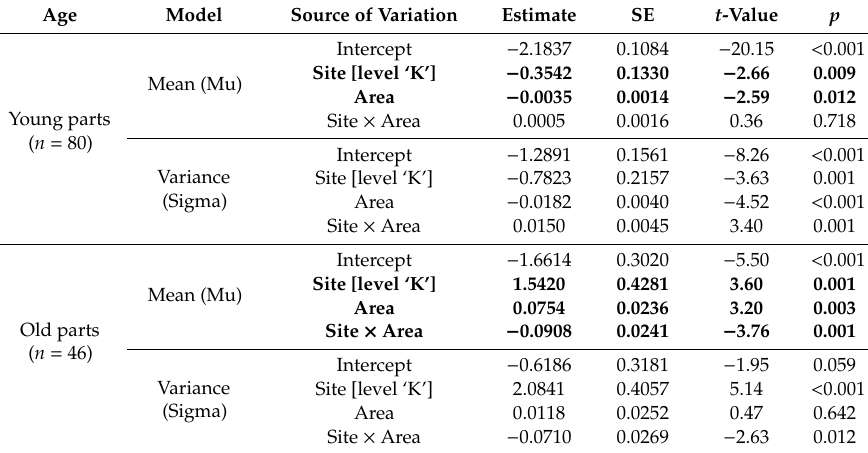
Table 5. E ff ects of plant part size (surface Area of the corresponding part, cm 2 ) and location (Sites K or V) on total cover of epibiosis on young and old parts of Phycodrys rubens in September 2015: beta-regression, mean (logit link) and variance (log link) modeled, frames pooled. Significant terms in a mean model highlighted in bold.